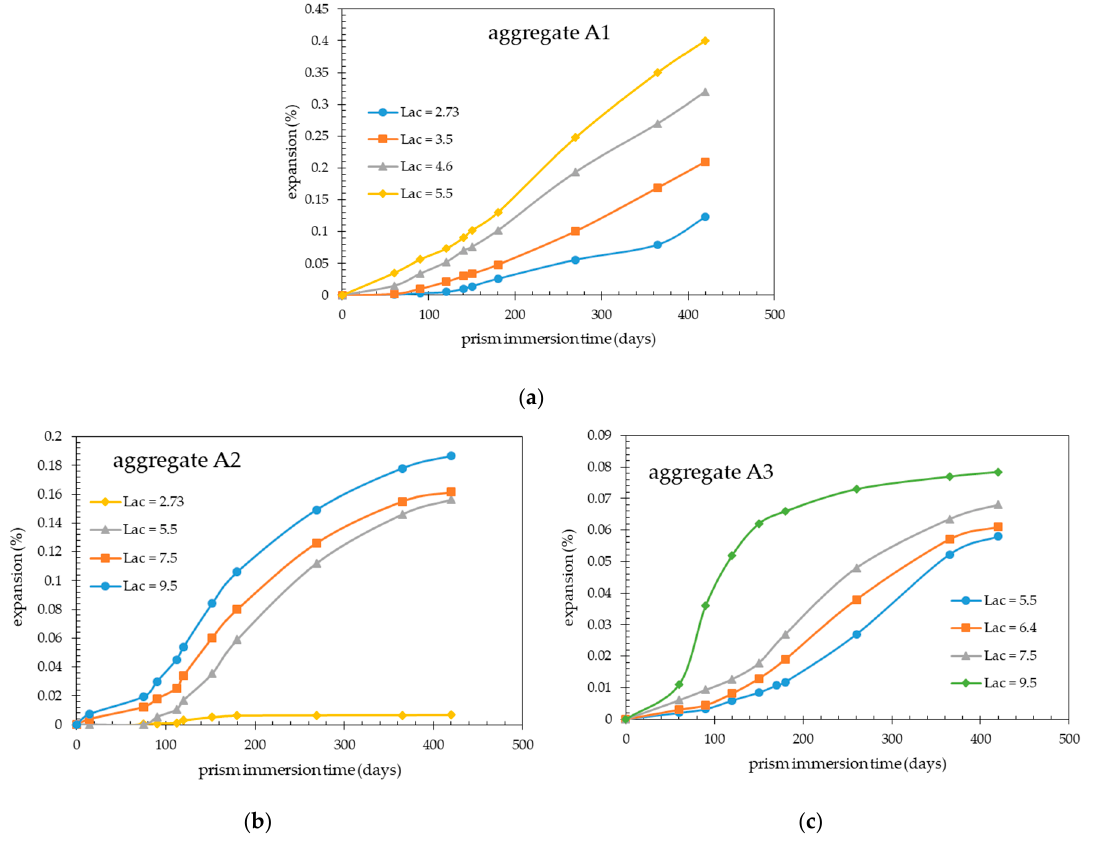
Figure 2. Expansions of concrete prisms with different aggregates and Lac values (kg Na 2 Oeq/m 3 ) during the accelerated CPT: ( a ) Aggregate A1; ( b ) aggregate A2; ( c ) aggregate A3.